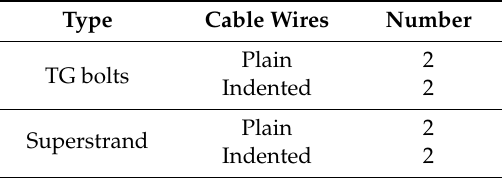
Table 5. Full-scale cable-bolt tests.